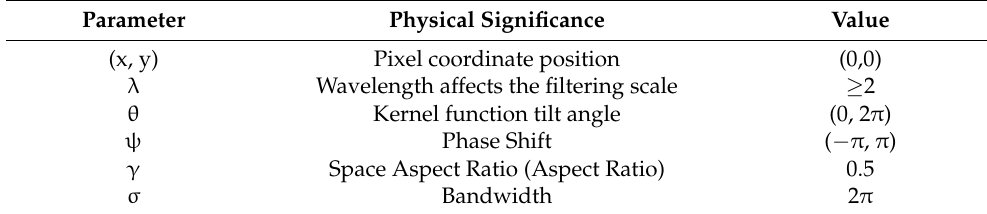
Table 2. The meaning and value of Gabor